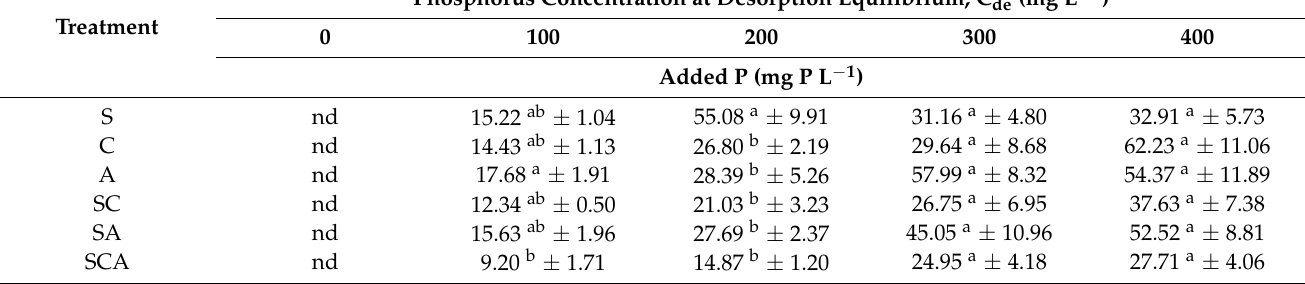
Table 5. Effects of treatments on phosphorus concentration at desorption equilibrium at different isonormal phosphorus